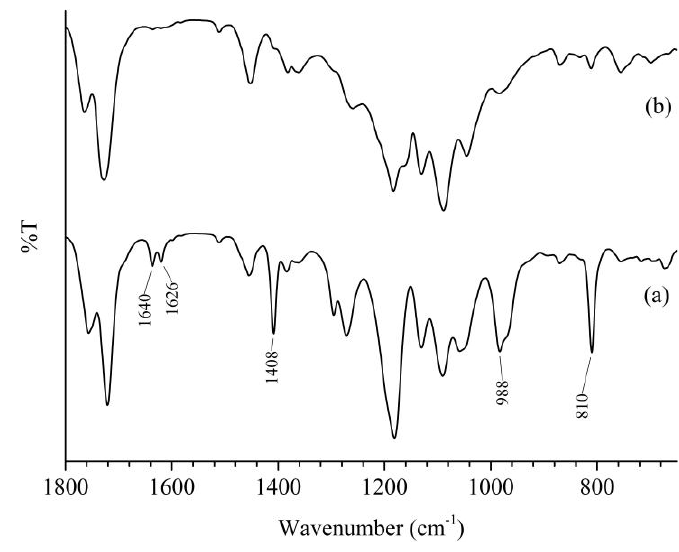
Figure 11. FTIR spectra of the screen printing ink made from BDAN-900 before ( a ) and after ( b ) UV curing. Table 6. Double bond conversion (%) of oligolactide acrylate-based UV-curable inks. Samples